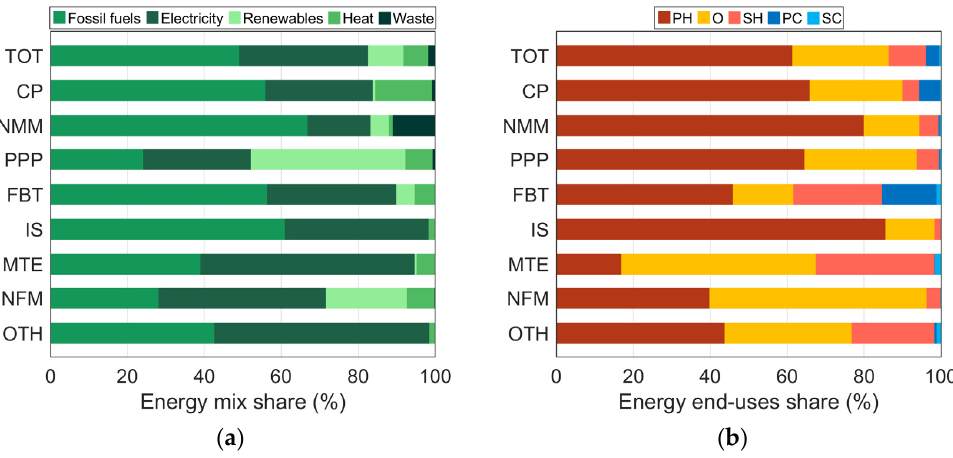
Figure 2. Breakdown of sectoral energy consumption: ( a ) supply side; ( b ) demand side. Based on data from [24,26]. (PH, Process Heating; O, Other end-uses; SH, Space Heating; PC, Process Cooling, SC, Space Cooling).